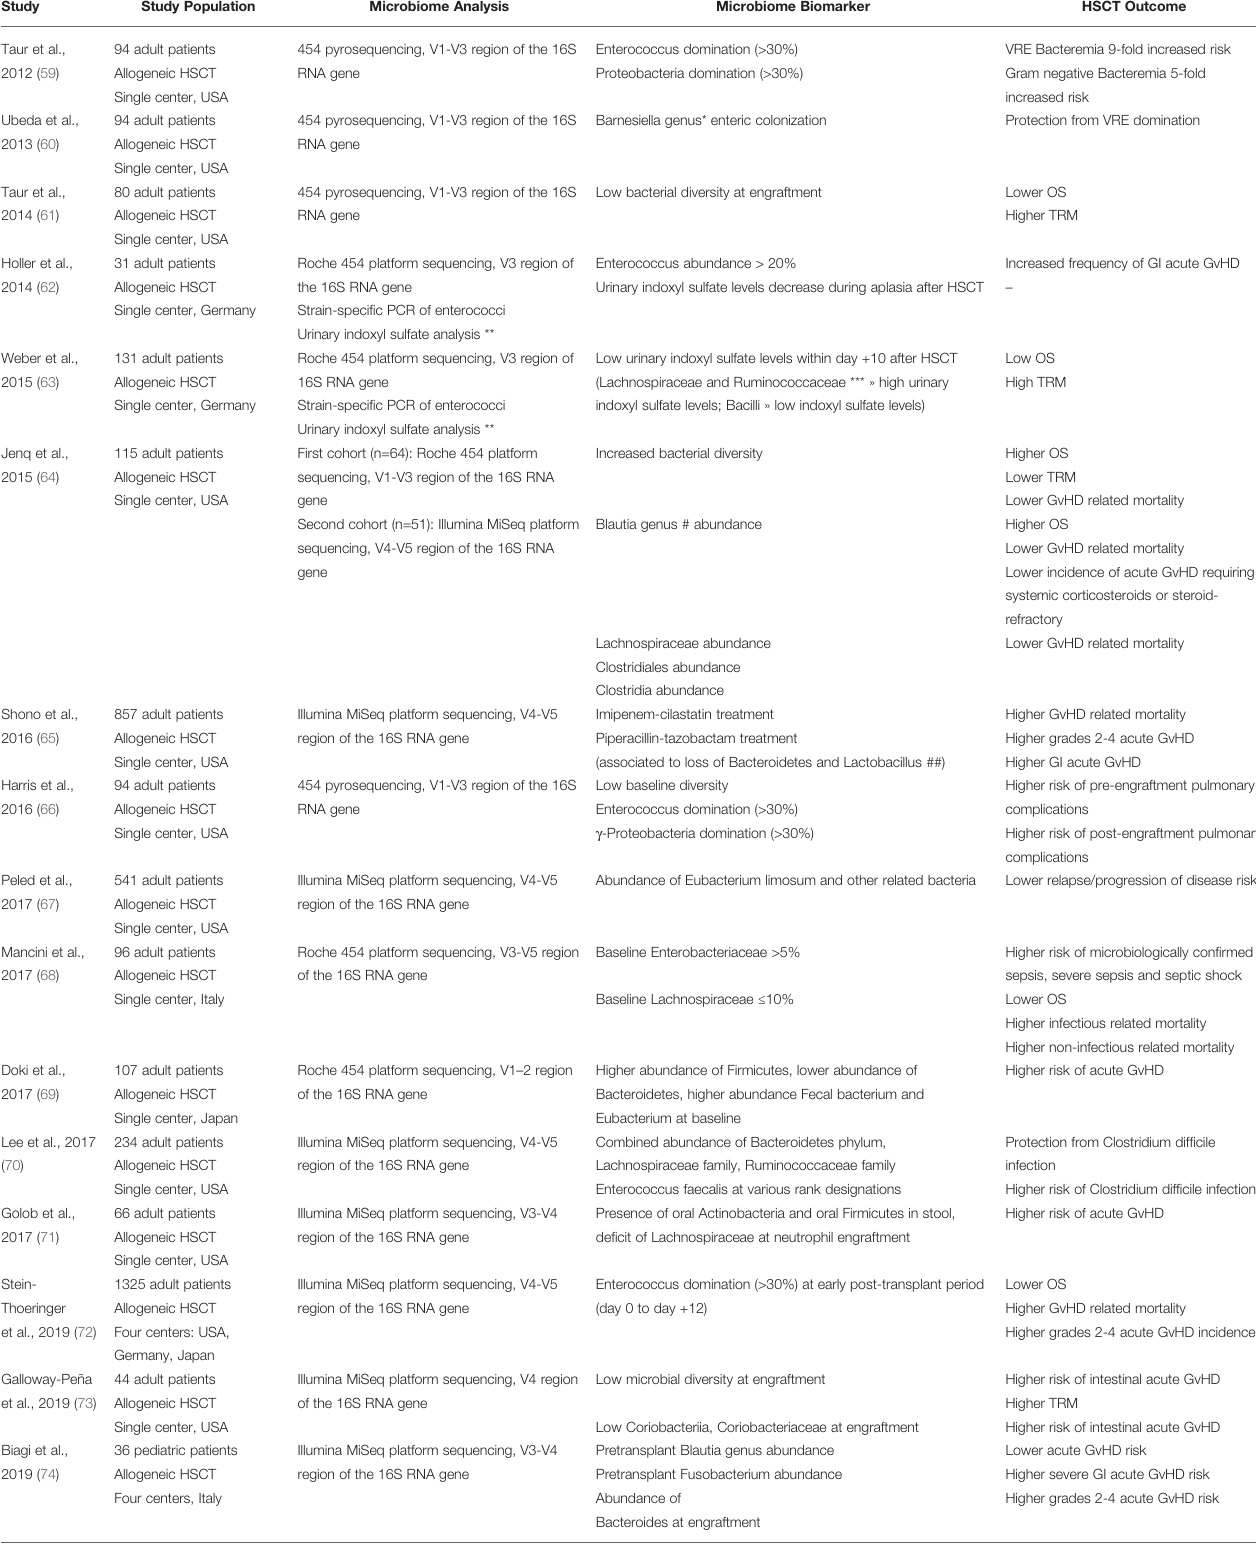
TABLE 1 | Impact of microbiome on HSCT